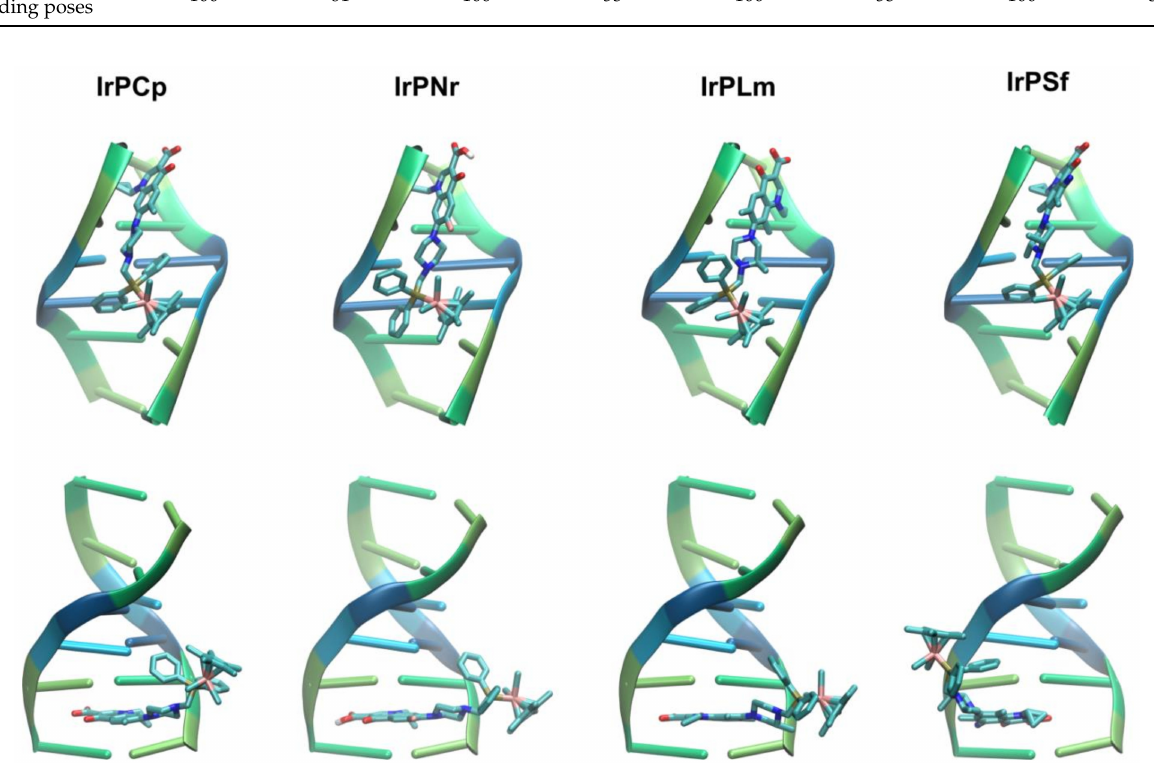
Figure 6. Representative structures of the binding modes of DNA-phosphinoiridium(III) complexes: top, minor groove binding; and bottom, threading